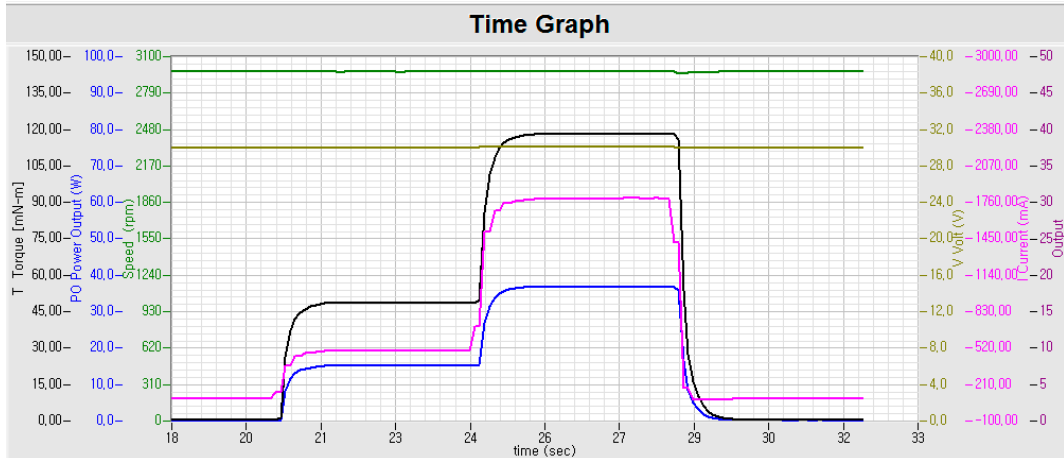
Figure 17. Output waveform of the motor performance tester. (Operating condition: ω r = 620 rad/s, permanent magnet temperature = 100 °C).